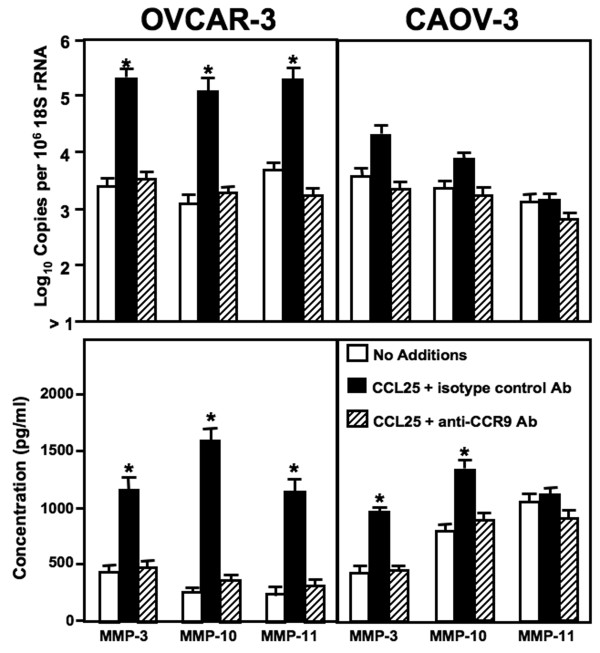
CCL25-induced stromelysin expression by ovarian cancer cells. Cells were tested for their ability to express stromelysins (MMP-3, MMP-10, and MMP-11) mRNA and protein. OVCAR-3 and CAOV-3 cells were cultured for 24 hours alone, with 100 ng/mL of CCL25, or 100 ng/mL of CCL25 + 1 μg/mL of monoclonal antibodies against CCR9. Total RNA was isolated and quantitative RT-PCR analysis was performed for mRNA expression of stromelysins (upper panel) and transcript copies are presented relative to actual copies of 18 S rRNA. Active stromelysins were quantified by Fluorokine and Biotrak assays in conditioned media (lower panel). MMP expression below the detectable limit of the RT-PCR is designated as below detection (BD). Asterisk(s) indicate statistical differences (p < 0.01) between untreated and CCL25-treated OvCa cells.